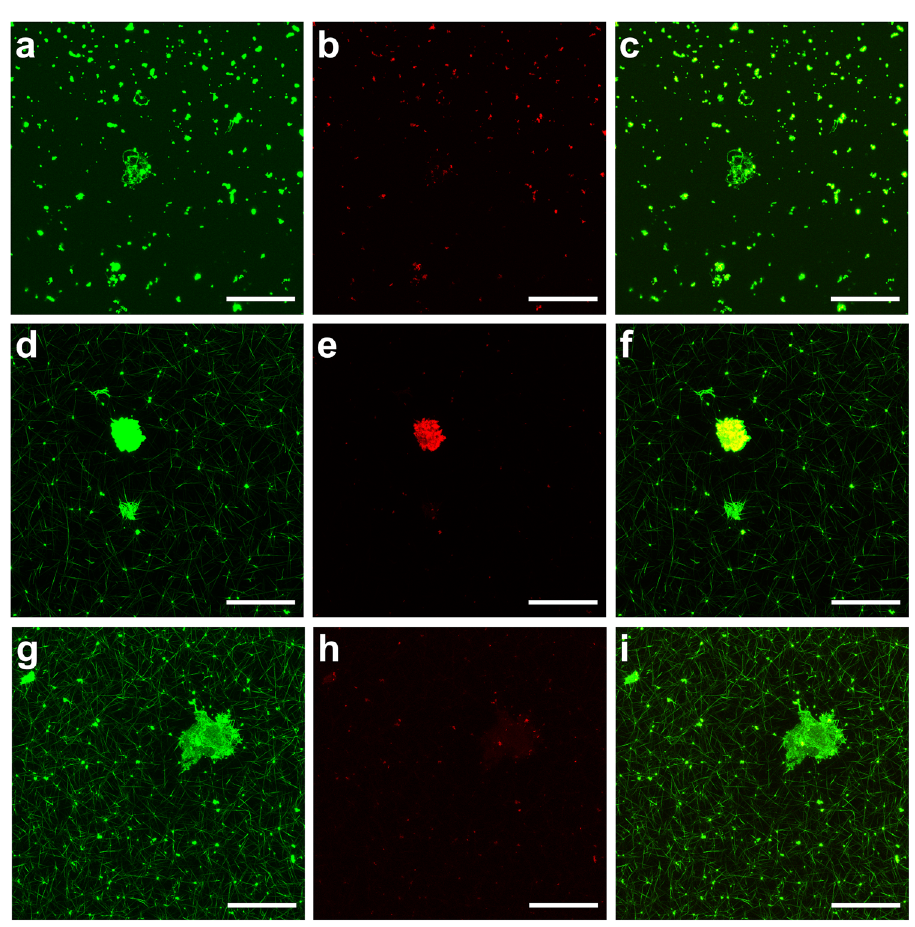
Fig. 1 Laser scanning confocal microscopy images of aggregates in plasma and plasma clots from patients with PE. Presence of aggregates in PE patient plasma prior to clot initiation with thrombin ( a – c ). Representative images of aggregates in PE patient plasma samples following the addition of thrombin showing platelet rich ( d – f ) and platelet poor ( g , h ) aggregates. Alexa Fluor 488 labelled fi brinogen is shown green ( a , d , g ) and DiOC6(3) staining is shown in red ( b , e , h ). An overlay of the two channels is also shown ( c , f , i ). Scale bars are 50 µ m.